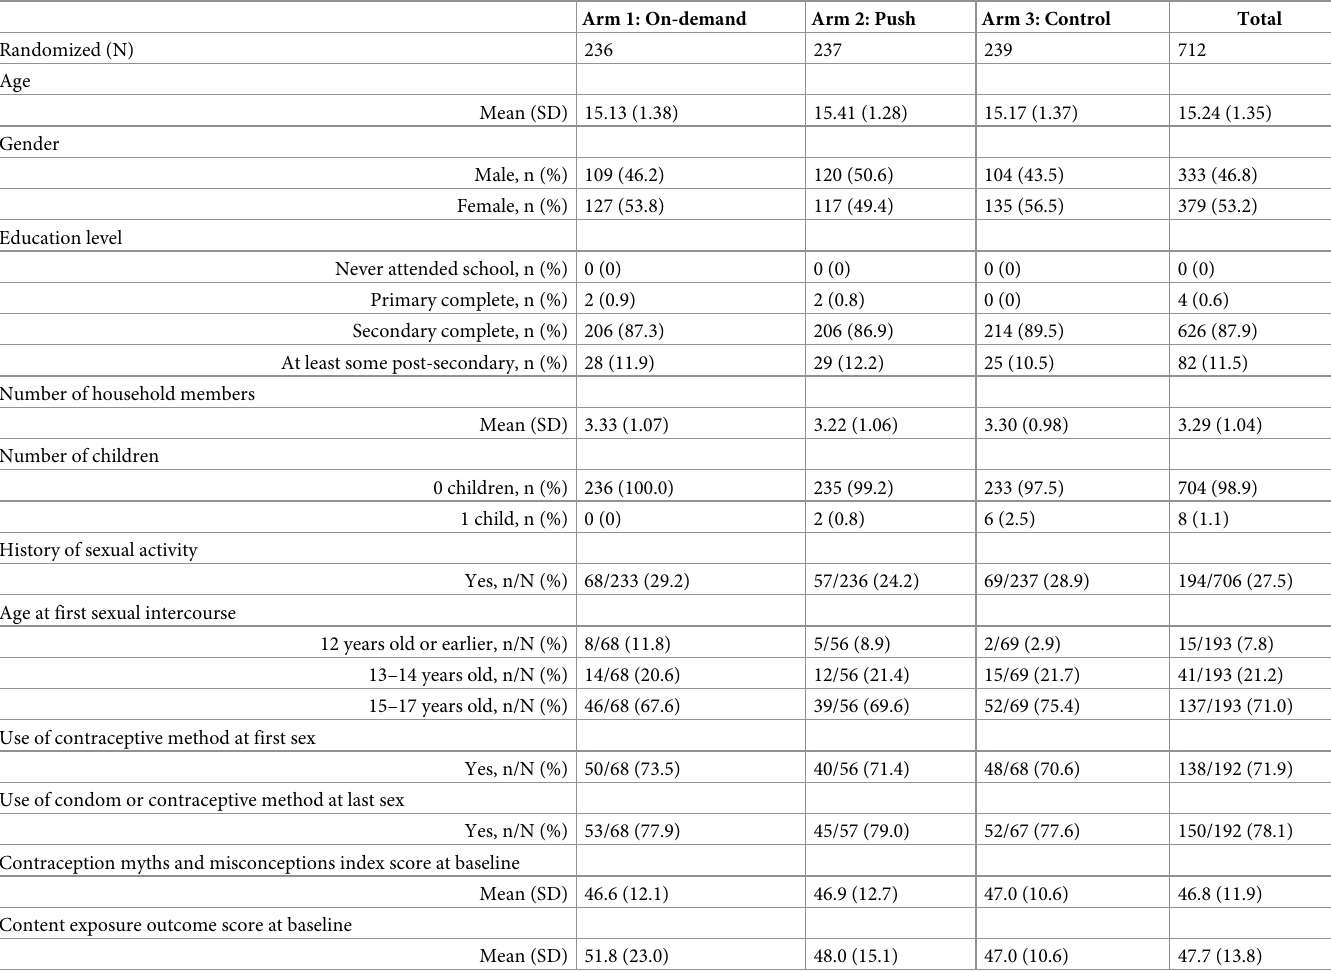
Table 1. Baseline characteristics, by randomization arm, of the study population (female and male 13–17 year olds, San Juan de Miraflores, Lima, Peru) (n =